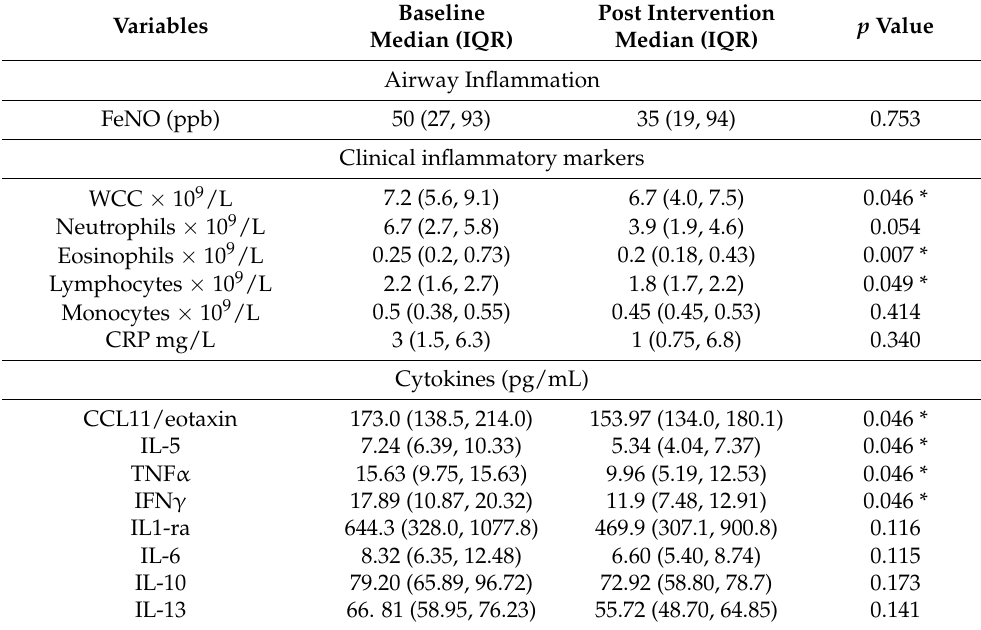
(Table 4). Plasma CCL11/eotaxin, IL-5, TNF α and IFN γ levels were also reduced by the exercise intervention ( p = 0.046) (Table 4). Table 4. Assessment of